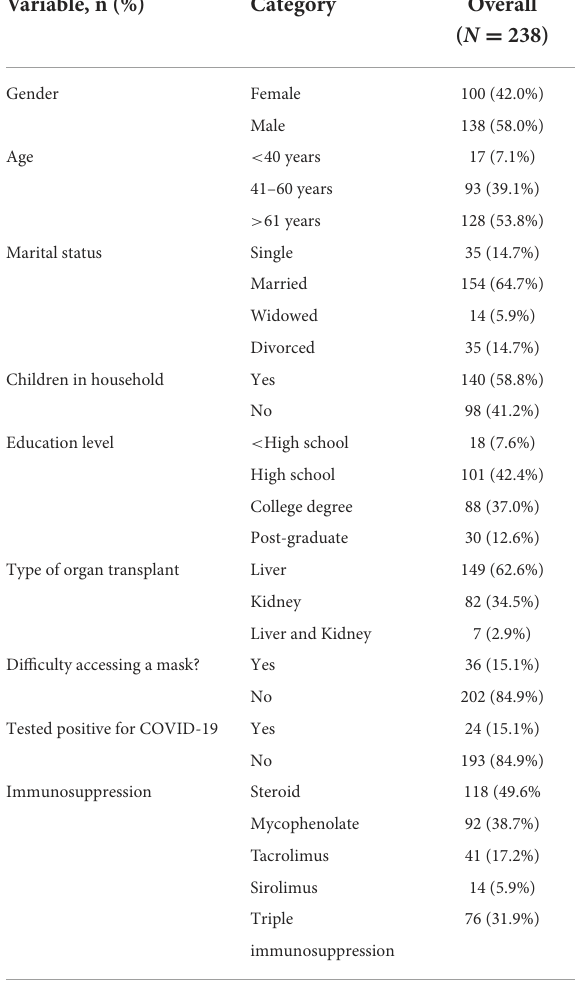
TABLE 1 Socio-demographic and clinical characteristics of the solid organ transplant patient study population. Variable, n